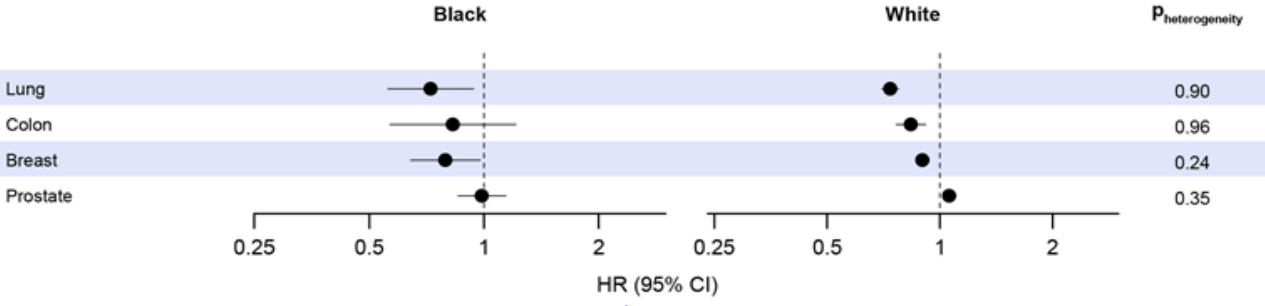
Figure F4-1. Summary Multivariable Hazard Ratios and 95% Confidence Intervals (CI) for a Higher (90 th percentile) versus Lower (10 th percentile) Level of Leisure-Time Physical Activity, by Cancer